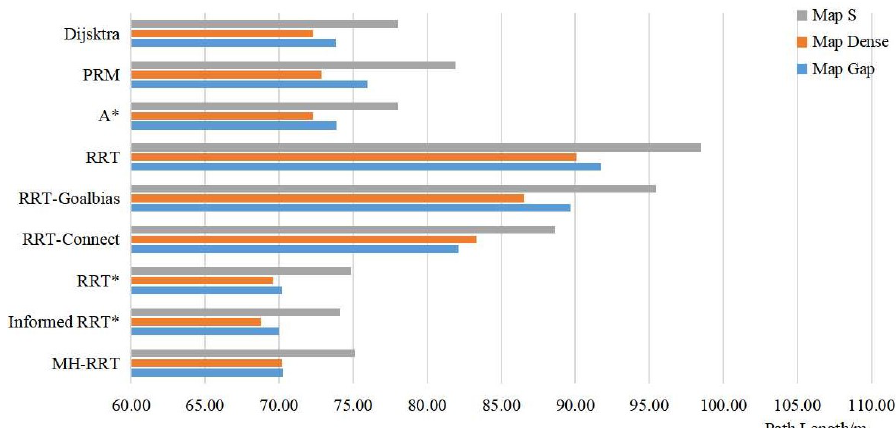
Figure 8. Result of planning time for the nine algorithms in three maps.